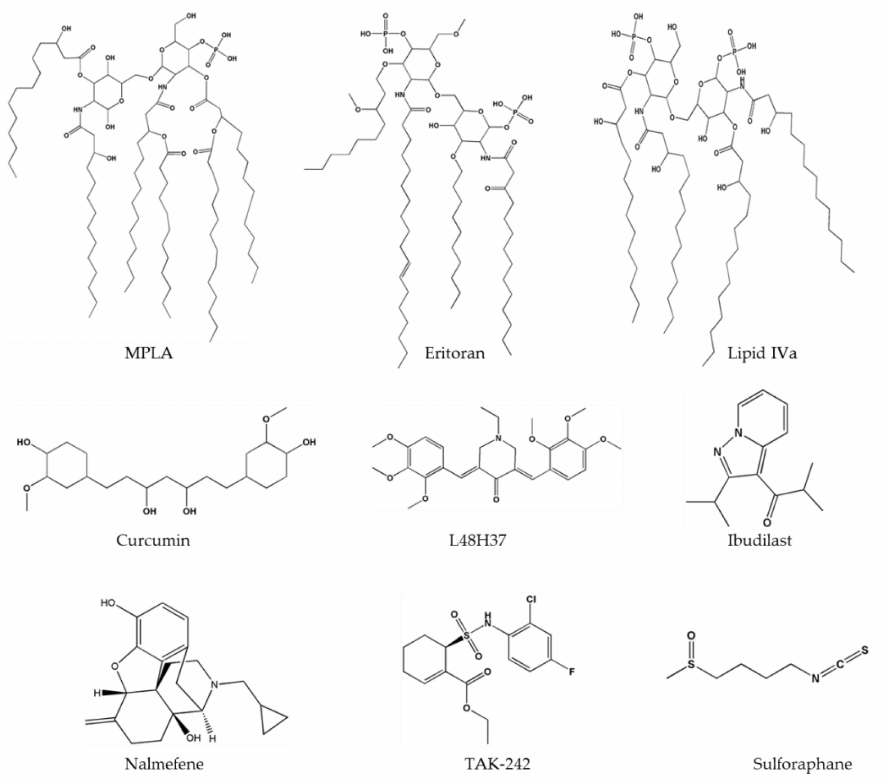
Figure 5. Two-dimensional structures of important TLR4